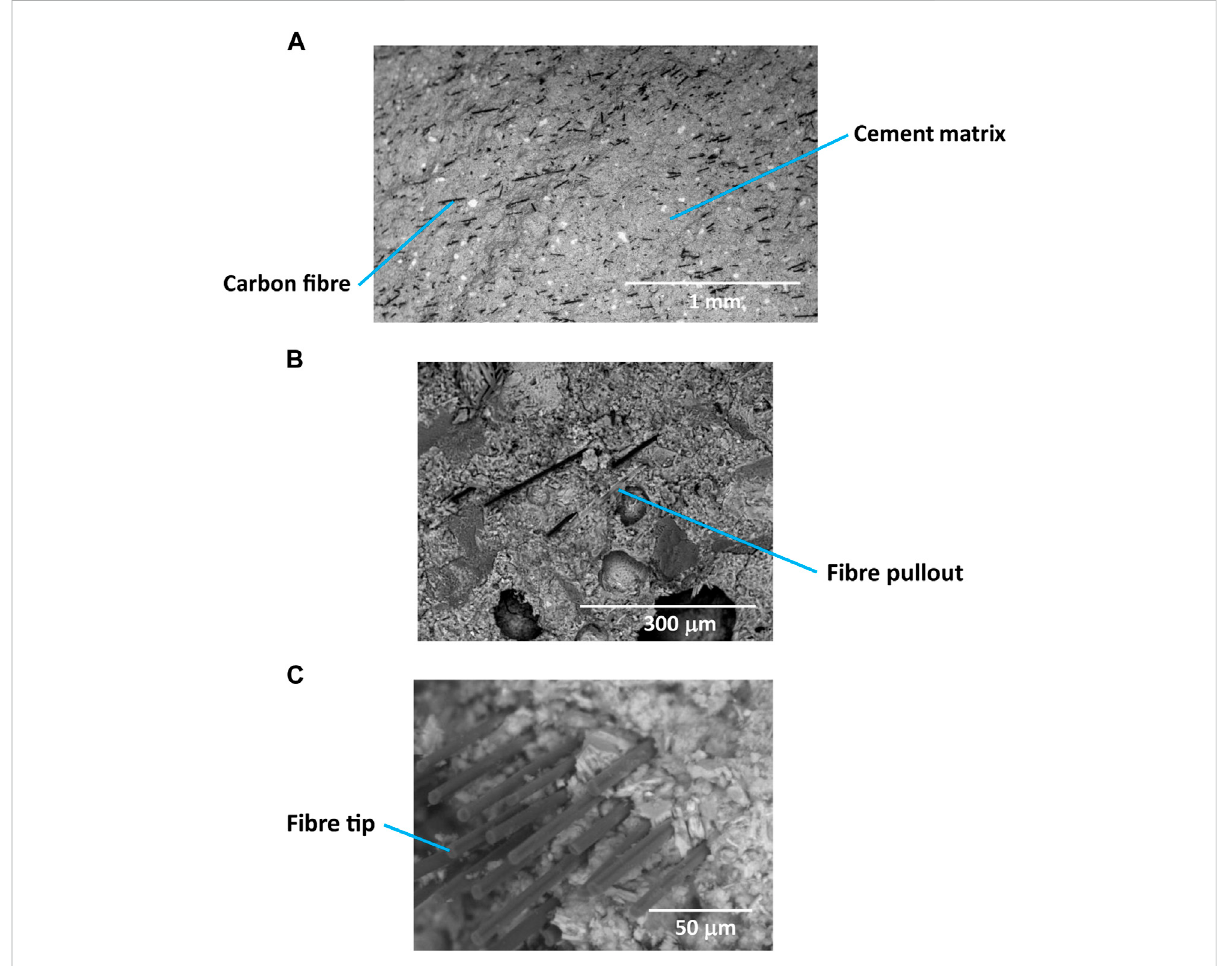
FIGURE 5 BSE images of the fi bres at the fracture surface of CF0.2 vol% (A) uniform dispersion of the fi bres (B) trace of fi bre pullout (C) exposed fi bre tips after